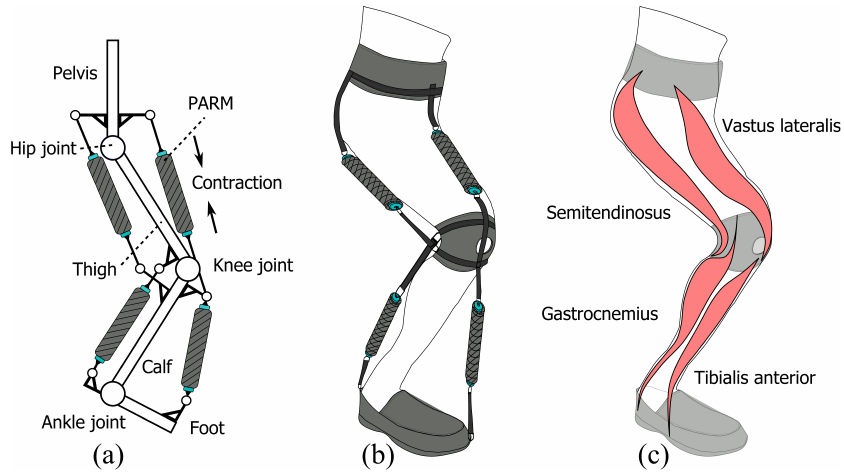
Figure 1. ( a ) Leg link system attached the PARMs and ( b ) Illustration of the trainee’s leg wearing the gait assistive suit. PARMs attached on the anterior and posterior surfaces of the trainee’s thigh and calf. Contraction force of these PARMs assists joint torque of the hip, knee, and ankle. ( c ) The target muscles of the gait assistive